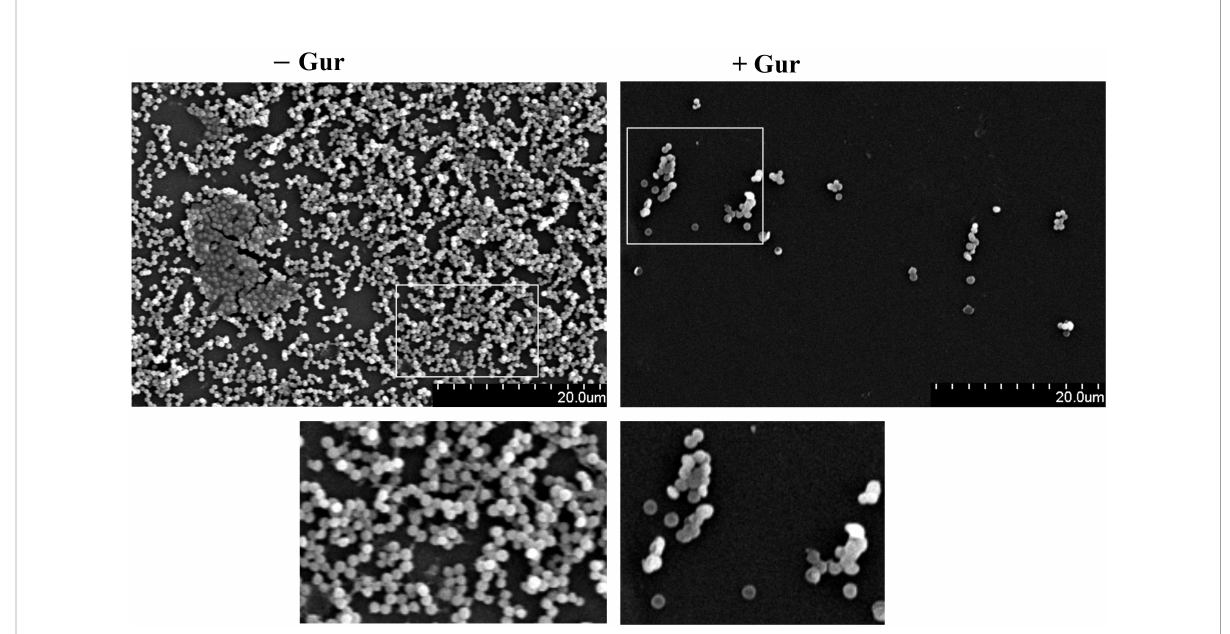
FIGURE 3 SEM view of Sa bio fi lm inhibition by gurmarin. Sa bio fi lms grown on Thermanox plastics for 16 h with gurmarin (1 µg/ml) or without were processed as described and viewed under SEM. Scale bar, 20 µm. A thick bio fi lm with extracellular polysaccharide fi brils is seen in the control (- Gur) and these are absent in the polypeptide-treated bio fi lm (+ Gur). Boxed regions are zoomed